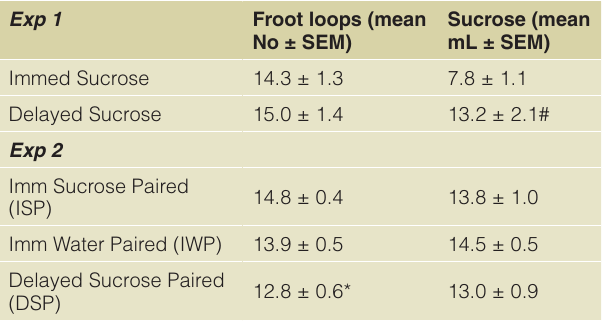
Table 1. Froot loop and sucrose